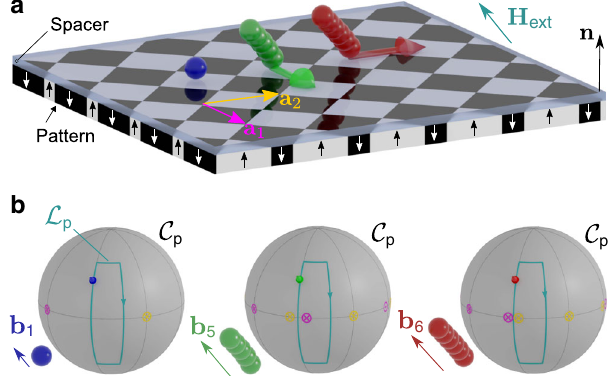
Fig. 1 Schematic of the colloidal transport. a A square magnetic pattern with lattice vectors a 1 and a 2 is magnetized with regions of positive (white) and negative (black) magnetization parallel to the vector normal to the pattern n . Spherical colloidal particles (blue) are placed on top of the pattern immersed in water. Due to the presence of a strong homogeneous external fi eld, some colloids self-assemble into rods of different length (green and red). b Our control space C p is a sphere that represents all possible directions of the external fi eld H ext . The direction of the external fi eld varies in time performing a closed loop L p . The colored arrow tip on the loop corresponds to the orientation of the external fi eld depicted in a . The orientation of the bipeds ( b 1 , b 5 , and b 6 ) is parallel to H ext . If the loop winds around special directions (yellow and pink equatorial circles), colloidal rods move as bipeds one-unit cell after completion of one loop ( a ). The topological properties of control space depend on the length of the rod, allowing the design of parallel polydirectional loops that move rods of different lengths simultaneously along different directions. Here, the loop Þ ¼ a transports b 5 -bipeds with fi ve colloidal particles by Δ r ð L (green 5 1 arrow in a ), b 6 -bipeds with six colloidal particles by Δ r ð L 6 Þ ¼ a 2 (red arrow in a ), and does not transport single colloids b 1